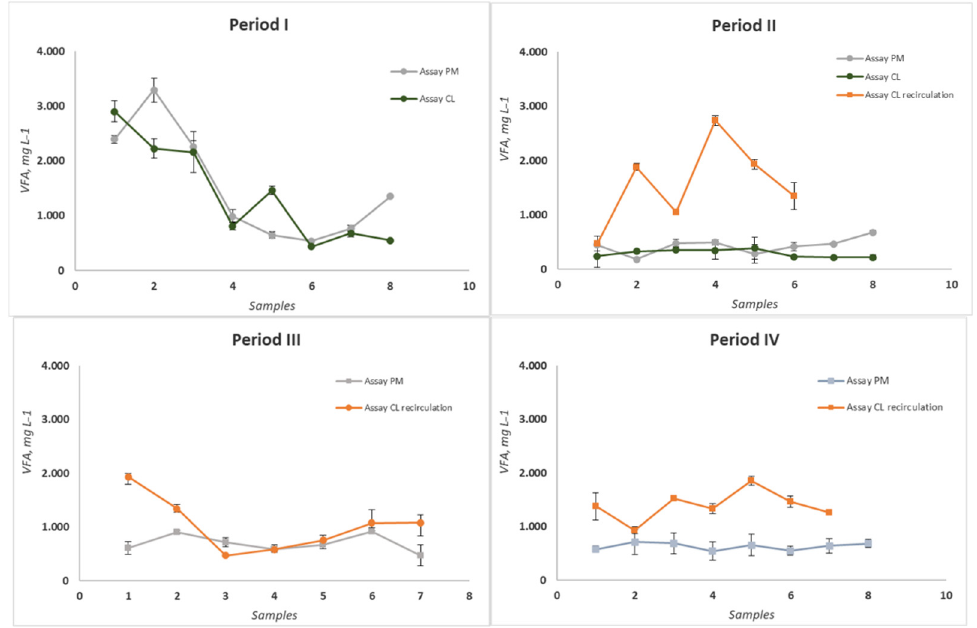
Figure 5. VFA evolution for each studied period at different OLRs.